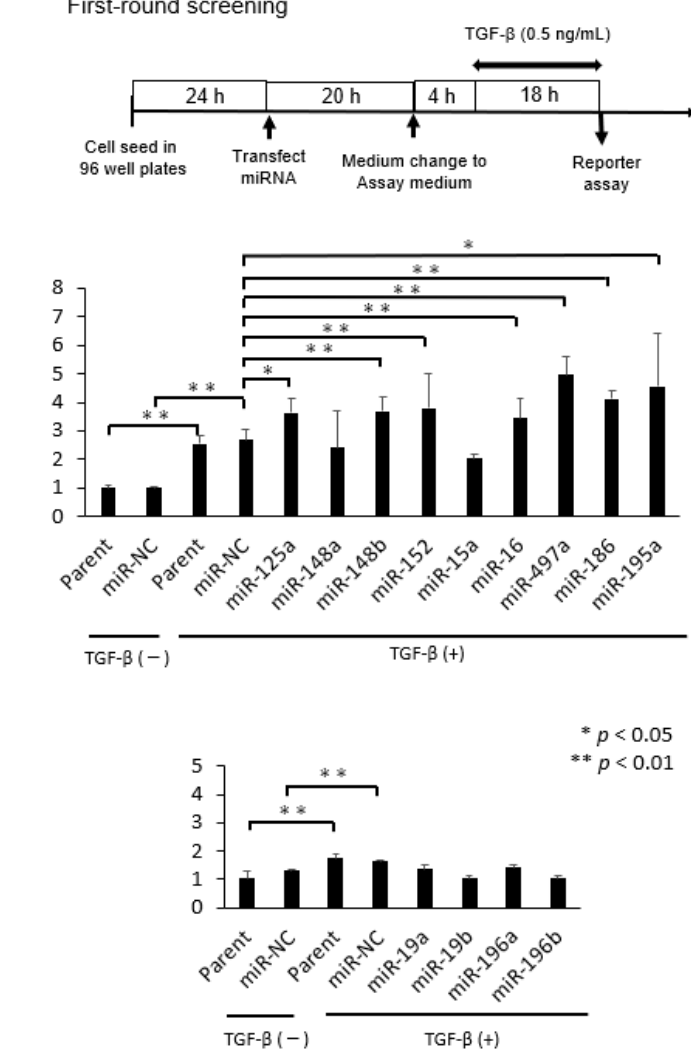
Figure 1. The first-round screening. ( A ) The experimental time schedule is shown here. ( B ) Of the 13 candidate miRNAs, 7 miRNAs significantly activated SBE reporter activity when compared to miR-NC (** p < 0.01,* p < 0.05, miR-NC vs. miR-125a-5p, p = 0.043; miR-NC vs. miR-148b-3p, p = 0.005; miR-NC vs. miR-152-3p, p = 0.005; miR-NC vs. miR-16-5p, p = 0.005; miR-NC vs. miR-497a- 5p, p = 0.003; miR-NC vs. miR-186-5p, p = 0.001; miR-NC vs. miR-195a-5p, p =